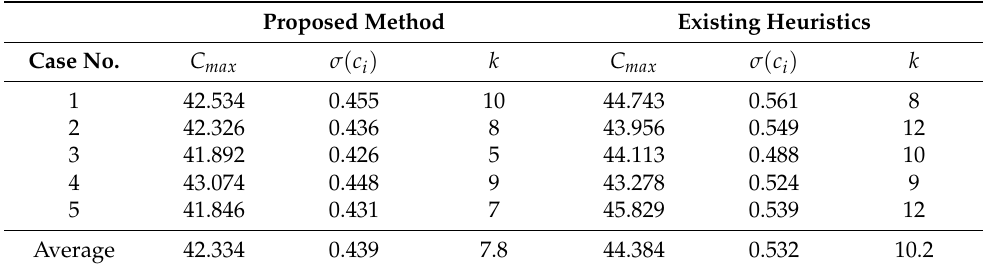
Table 5. Result of the experiment for resilience in instance phase (unit: hour).